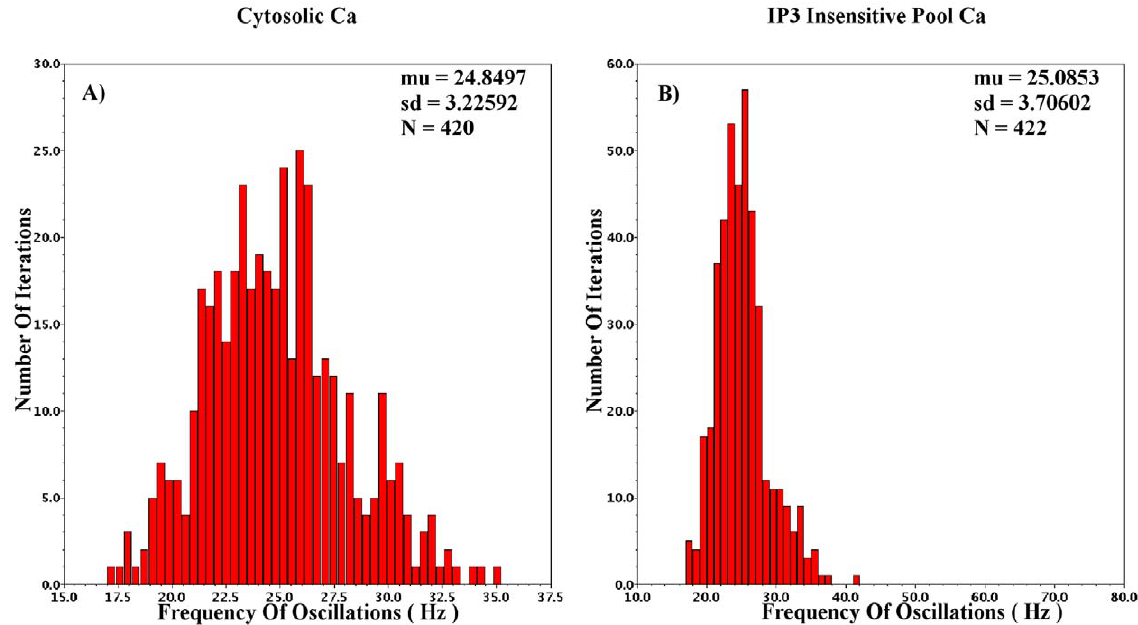
Figure 18. Monte Carlo analysis for the m ~ n ~ p ~ 1 intracellular Ca 2 + Log-Domain circuit. 600 iterations have been performed and the percentage of iterations corresponding to successful oscillations was above 70 %